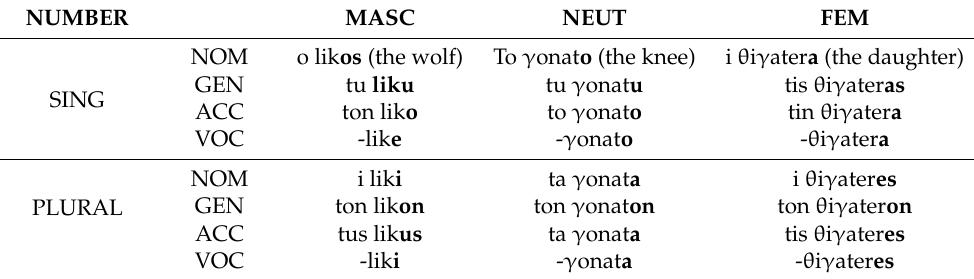
Table 4. Morphological marking of gender in